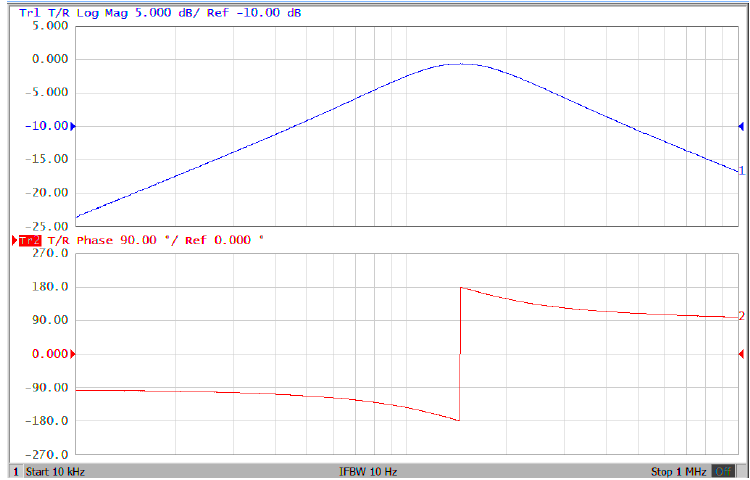
Figure 32. Experimentally observed gain and phase responses of the IBP filter realized in case I.